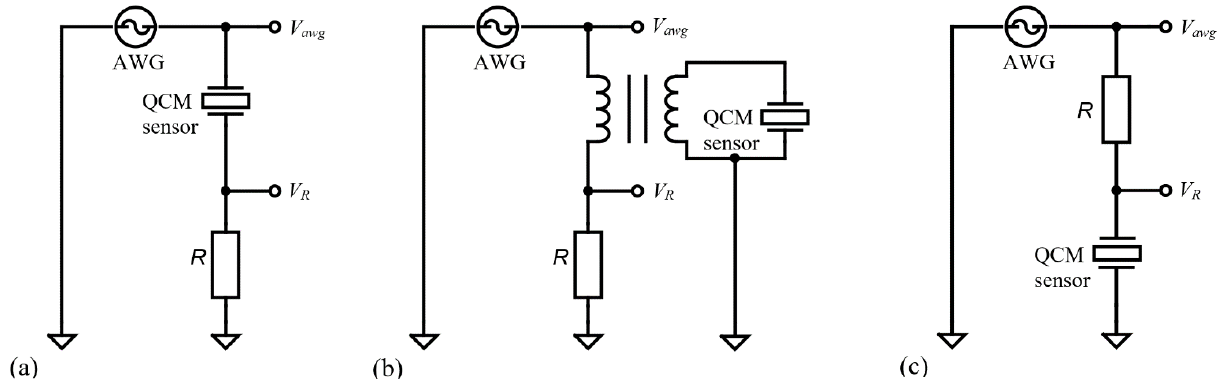
Figure 2. Impedance Analysis method: ( a ) wide dynamic range half-bridge configuration, ( b ) with balun transformer and one grounded electrode, and ( c ) QCM sensor connected to the